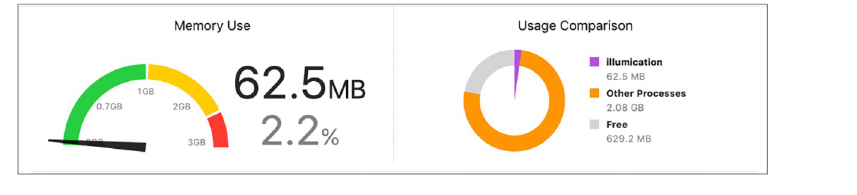
Fig 8. Performance testing.